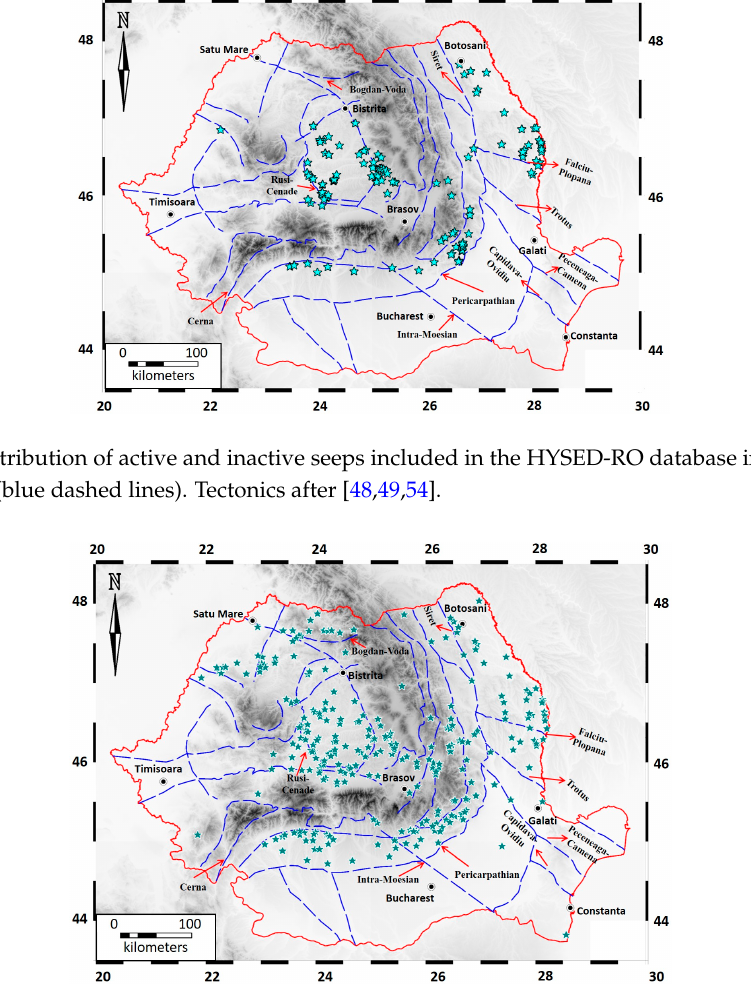
Figure 5. Distribution of uncertain seeps in relation to major faults (blue dashed lines). Tectonics after